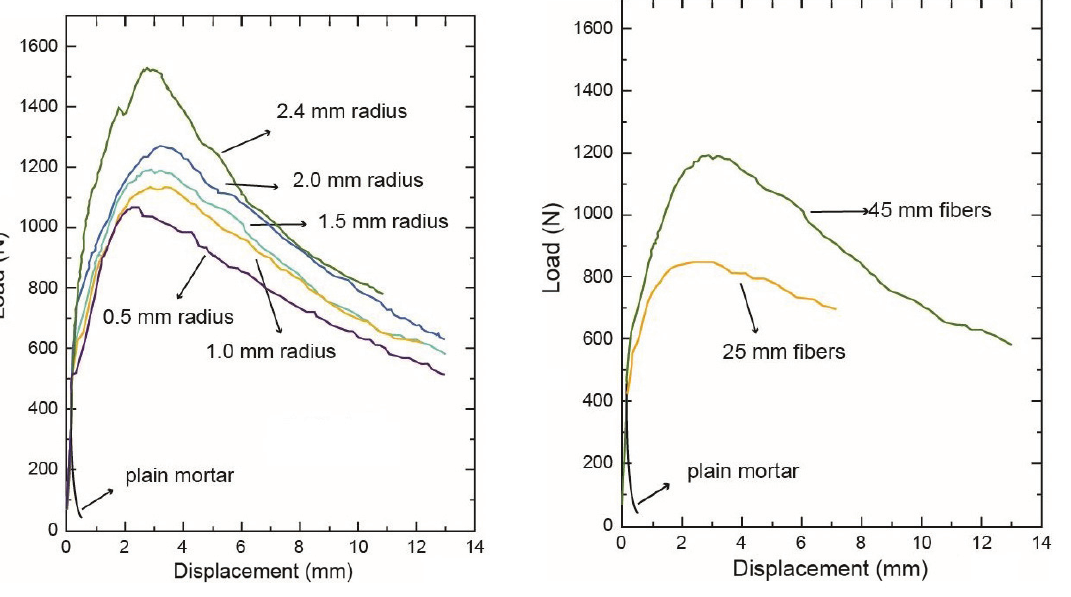
Figure 5. Mortars’ load-displacement curves in three point bending for 1.5 mm root